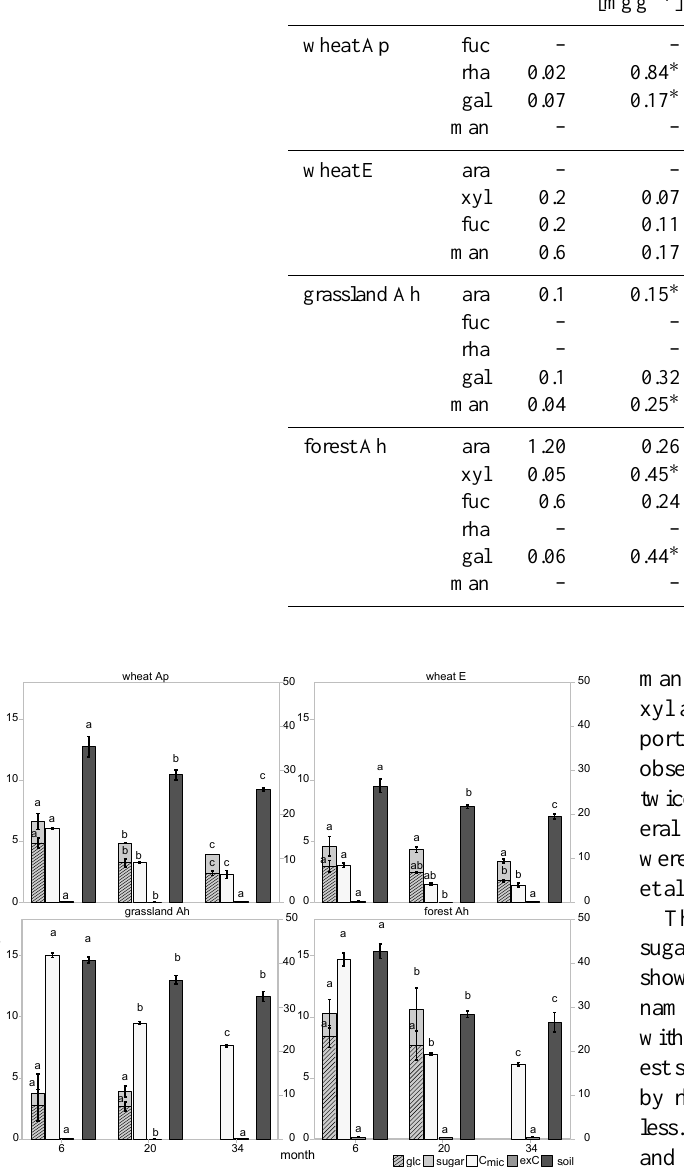
Figure 3. Partitioning of the labelled C into microbial biomass ( C mic ), K 2 SO 4 -extractable carbon (exC), glc and sum of all sugars (left axis) and bulk soil (right axis) in wheat Ap and E, grassland Ah and forest Ah after 6, 20 and 34months of incubation. Different let- ters indicate significant differences ( p <0.05) within one treatment over time. Means ± standard error ( n =